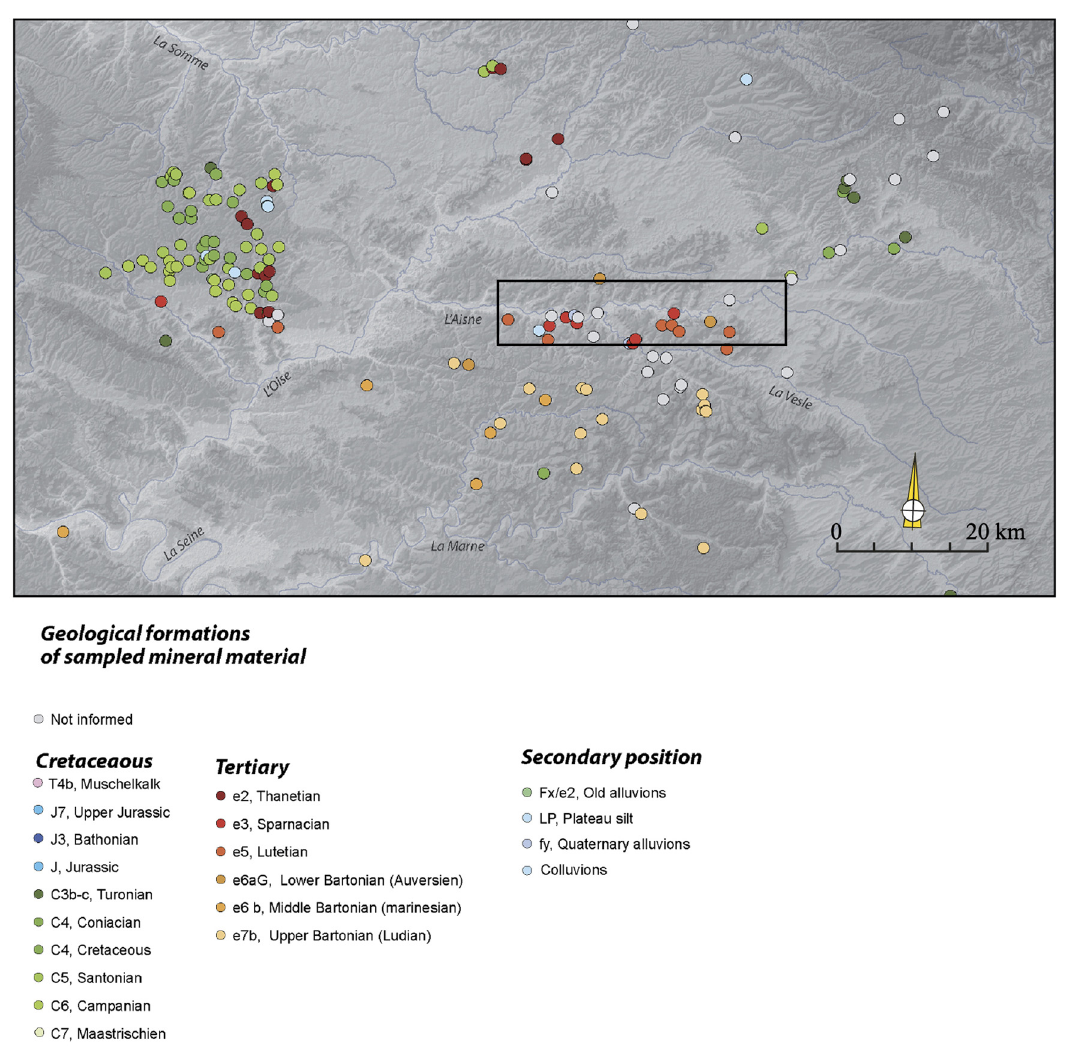
Figure 6: Map of siliceous rocks inventoried in the reference collection of the Aisne valley ( after Lietar et al., 2014 ) . Champagne fl ints are not indicated; they are located further